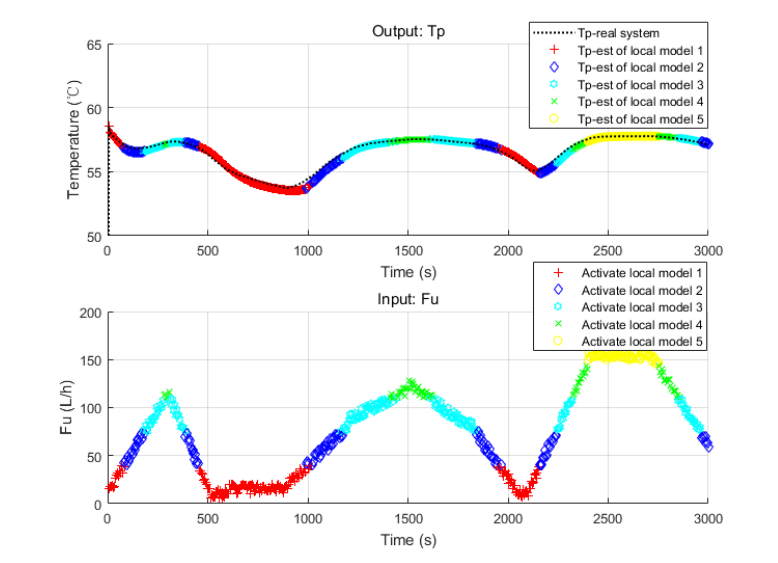
Figure 3. Verification of the first layer model bank using inputs of integral range.